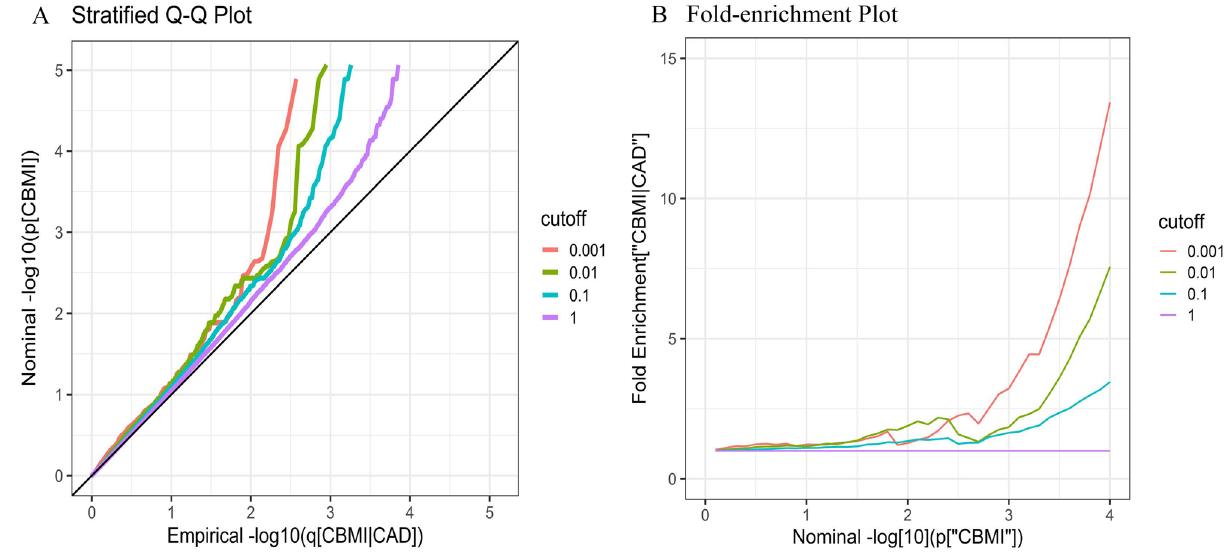
Figure 1. Stratified Q–Q plot ( A ) and Fold-enrichment plot ( B ). Stratified Q–Q plot: Nominal versus empirical − log ( p ) values in CBMI as a function of significance of association with CAD at different levels. Fold- 10 enrichment plot: Enrichment versus nominal − log 10 ( p ) values for CBMI as a function of significance of the association with